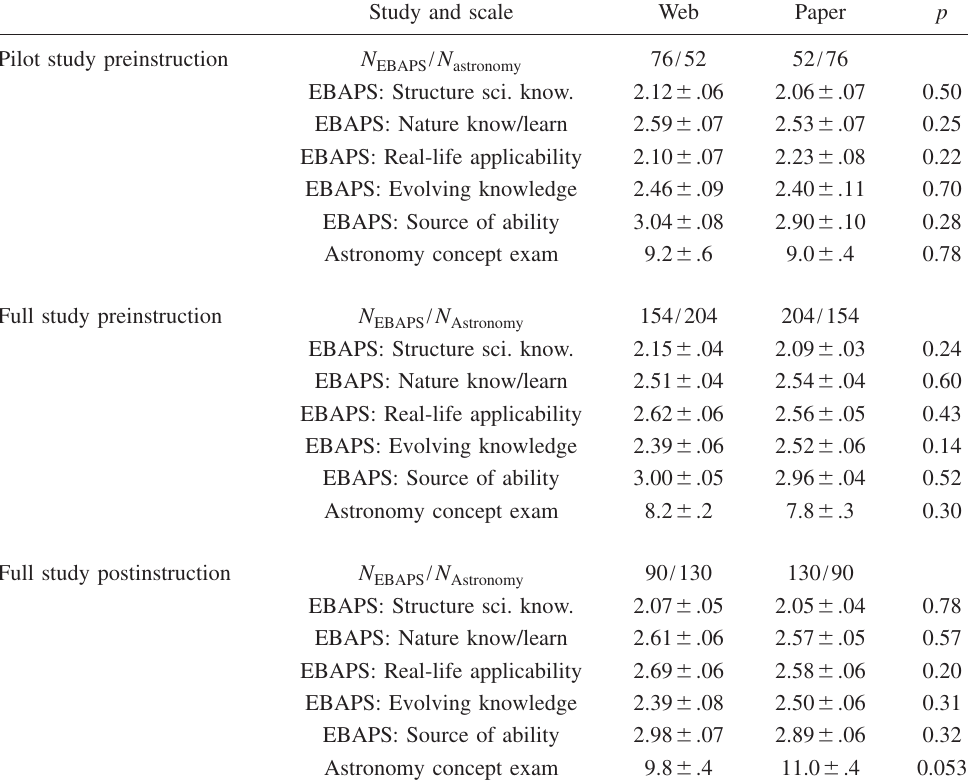
TABLE I. t -test comparison of student performance on web and paper for both assessments on pilot and full-scale studies. N is the number of students taking the astronomy or EBAPS assessment in that mode, along with the average score and standard error of the mean for each scale. The last column provides the probability measure and shows that no significant differences are found due to the mode of